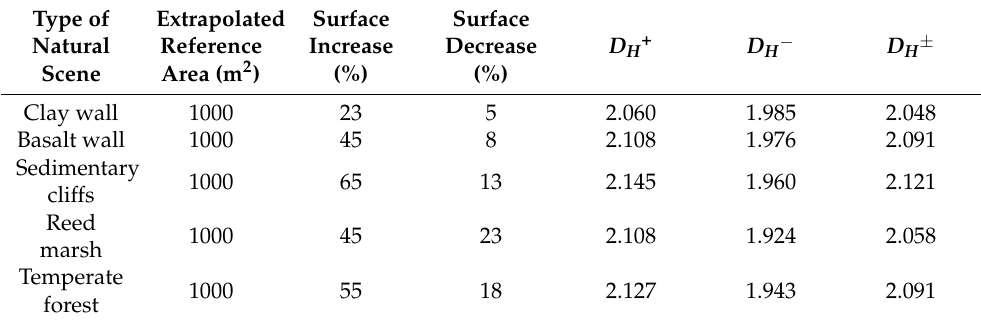
Table 2. The Hausdorff dimensions of natural scenes surrounding a building or an object. Surface estimates were made through the use of digital photography, image processing and Google Earth